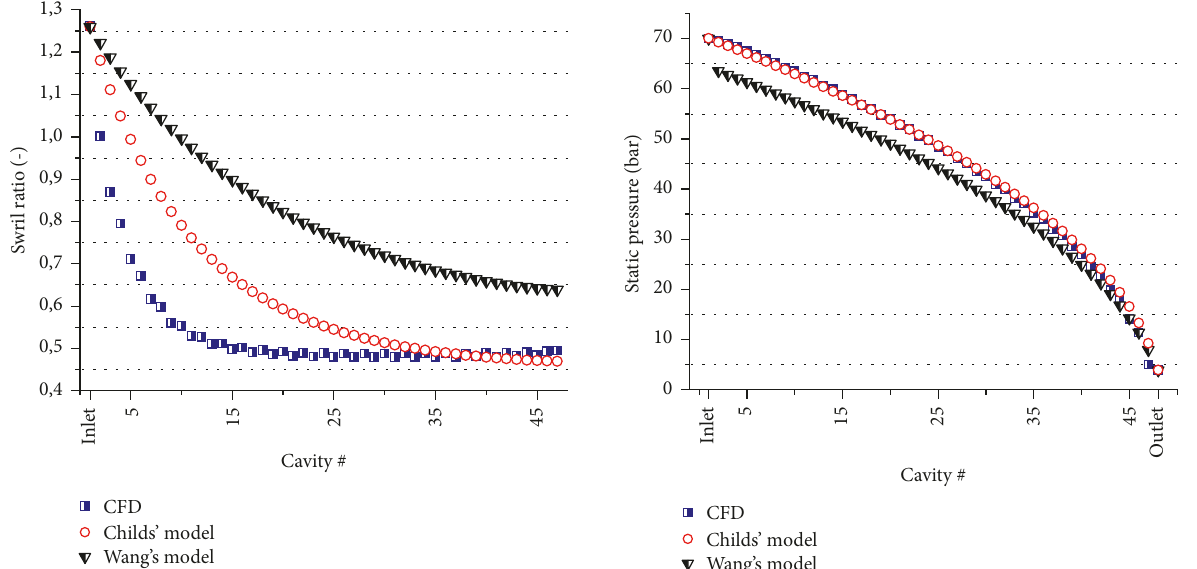
Figure 6: Comparison of the swirl ratio and of the static pressure in the seal cavities evaluated with the CFD, Childs’ model, and Wang’s model.